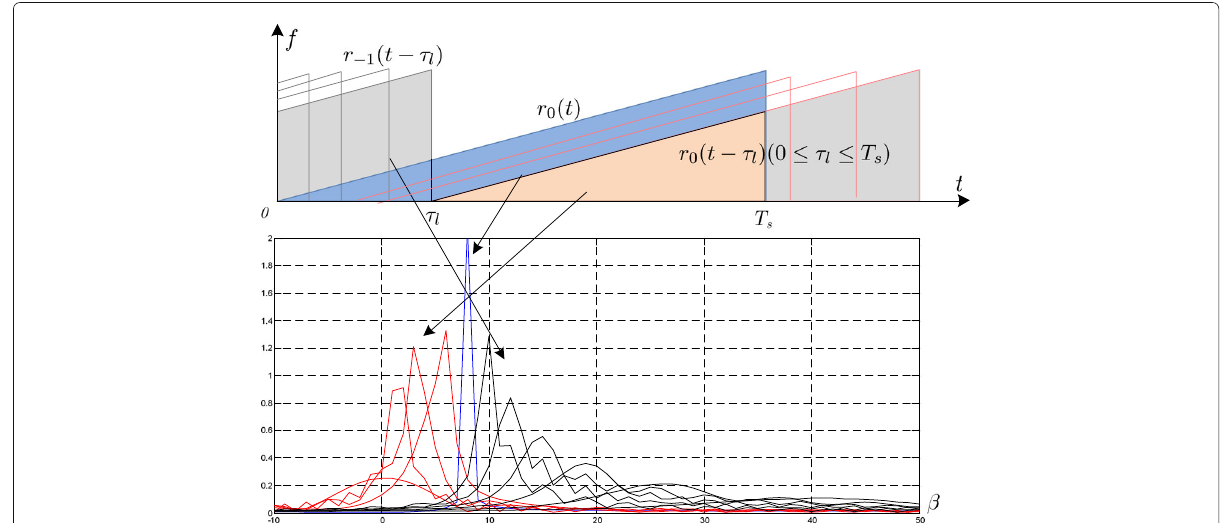
Fig. 2 BFT on the multipath chirp-rate signal. The figure shows the BFT output of the chirp-rate signal in multipath environment